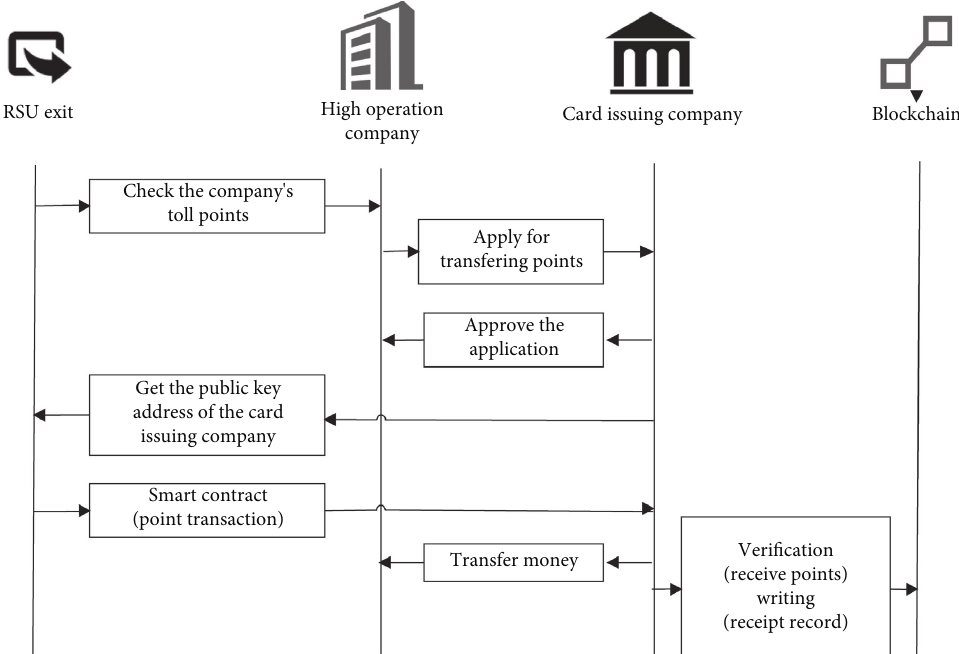
Figure 7: Point transaction between the card issuing company and RSU.